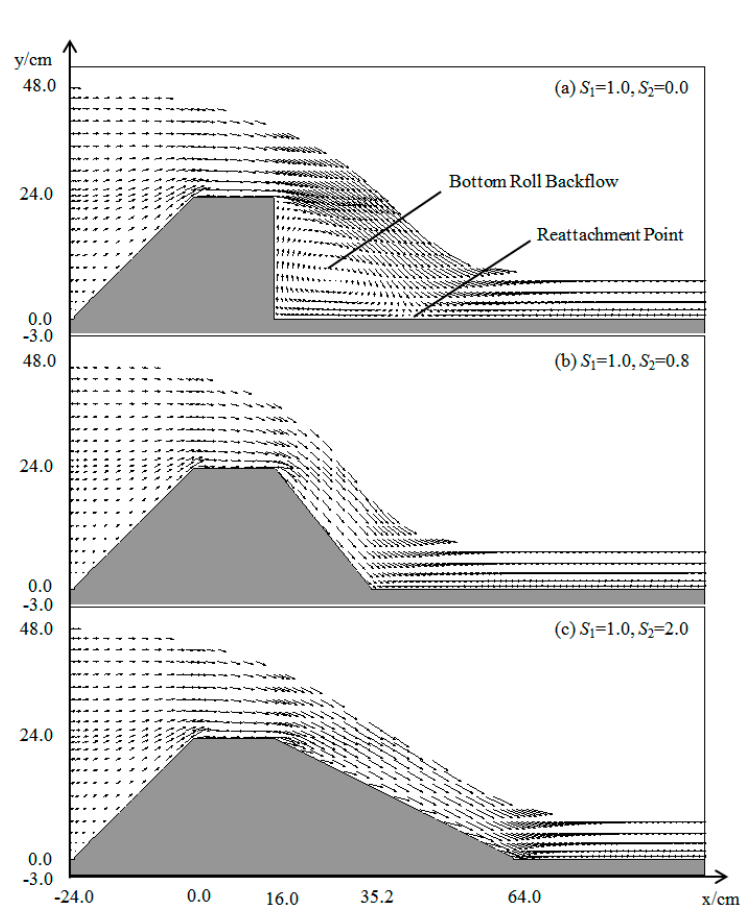
Figure 9. Comparison of flow regimes over weirs at S 1 = 1.0 with H / δ = 1.41 for S 2 = 0.0, 0.8 and 2.0.